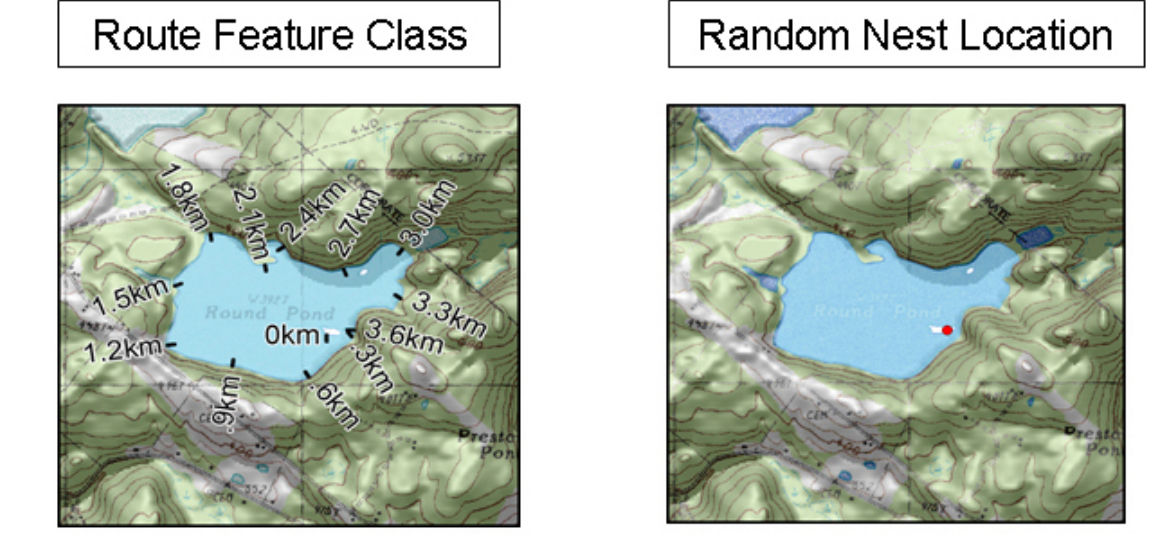
Fig. 4. Maps illustrating how, using GIS, route feature classes were generated along the perimeter of each lake so that all features of a lake, including islands, are treated as a single entity. Along each route, a randomly chosen non-nest site was located on lakes that were monitored for loons but had no loon